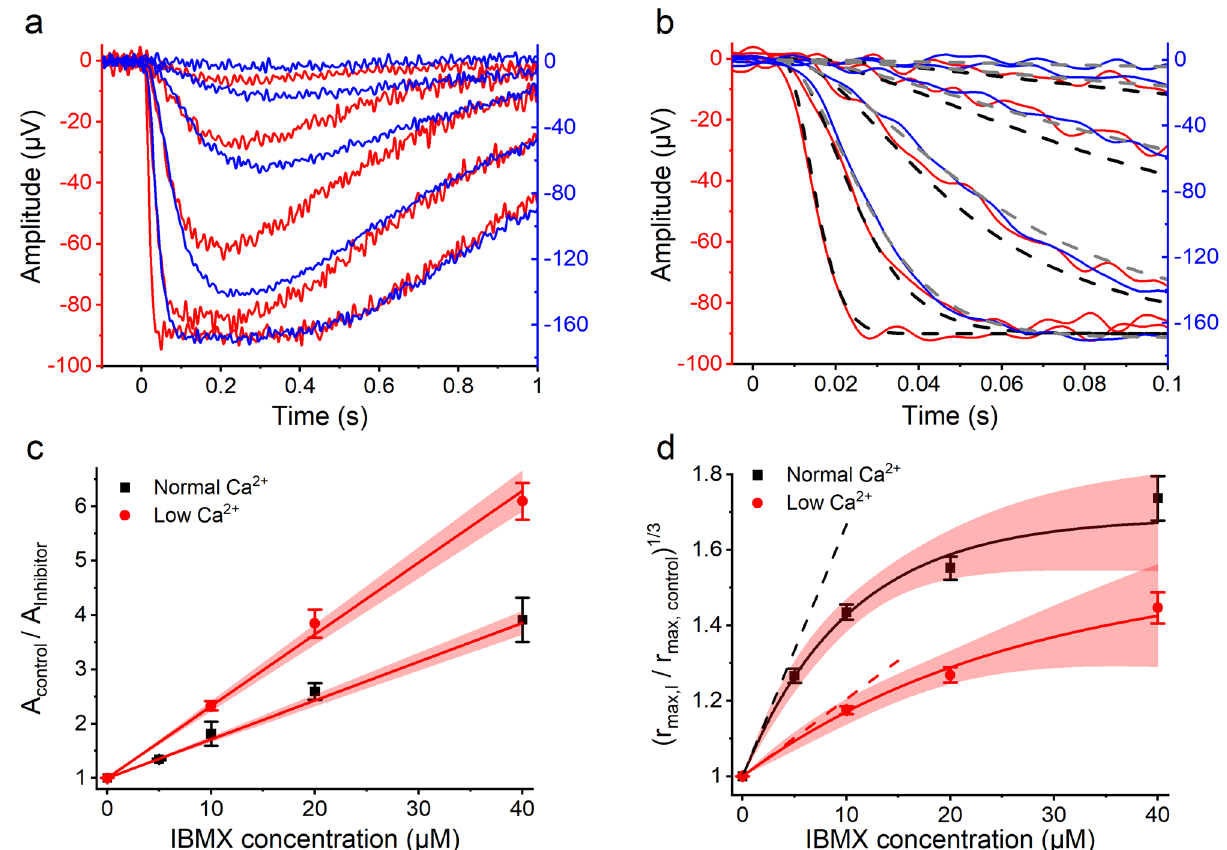
Figure 4. ( a ) Response families recorded in low Ca 2+ solution without IBMX (red traces) and with 40 µM IBMX (blue traces). The flash strengths were 3.42, 13.6, 54.1, 216, and 858 R*rod −1 in both solutions and responses are averages from 1 to 3 repetitions. ( b ) Determination of amplification constants for response families shown in Fig. 4a by fitting the flash response model to the response leading edge (Eq. (15)) to the activation phase of the responses. τ R was locked to 26 ms and τ PDE to 199 ms, which was determined separately for the concerned retina from Pepperberg plot. Constant delay of 7 ms was used for the fits. Fitting gave an amplification constant of 27.7 s −2 in low Ca 2+ without IBMX (black dashed lines) and 4.9 s −2 in 40 µM IBMX (gray dashed lines). ( c ) Determination of inhibition constant against light-activated PDE6 ( K I , light ). Fitting of Eq. (8) to the pooled data gave an inhibition constant of 13.9 µM and 7.6 µM for normal and low Ca 2+ , respectively. The intercept of the linear fit is fixed to 1. ( d ) Determination of inhibition constant against basally activated PDE6 ( K I , dark ). The figure shows the relative increase in the maximal LERG-OS amplitude right after the light turn-off in the cGMP clamp (see Fig. 3). The exponential fits to the cGMP clamp data extrapolated to zero inhibitor concentration gave 15.0 µM and 49.0 µM for K I , dark in normal and low Ca 2+ , respectively (see Eq.